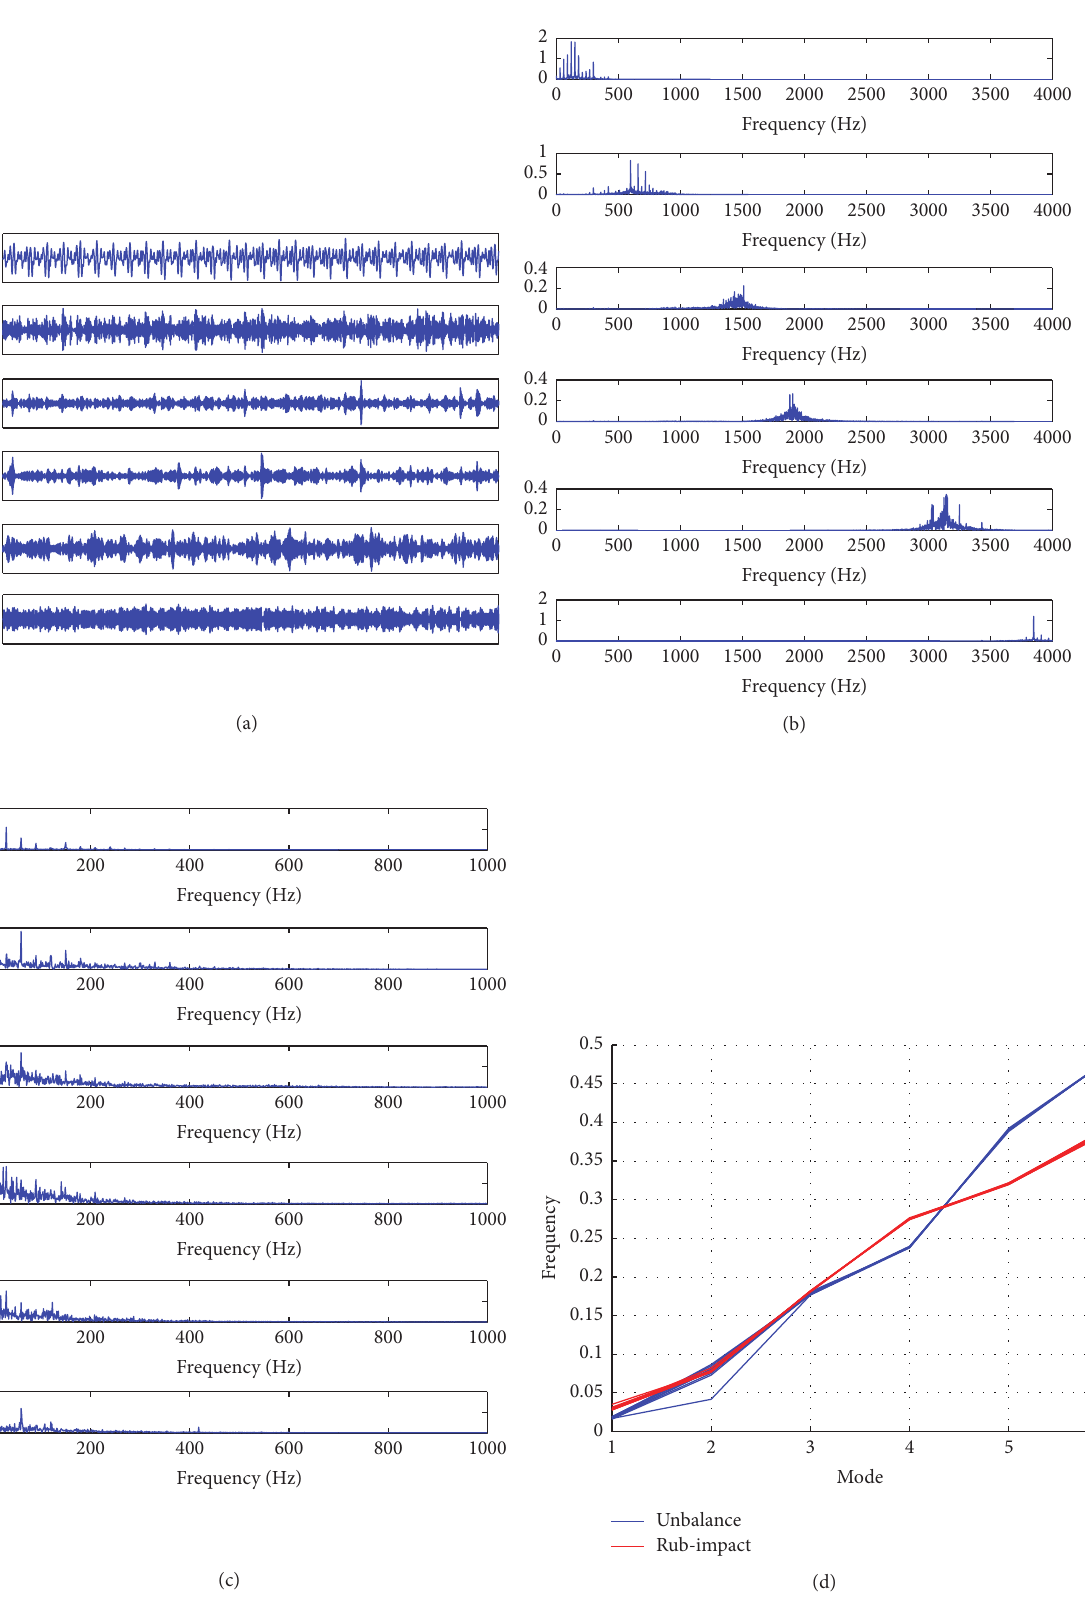
Figure 8: VMD subsignals (a), their frequency spectrums (b), and envelope spectrums (c). Center pulsations for all the training data concerning unbalance and rub-impact